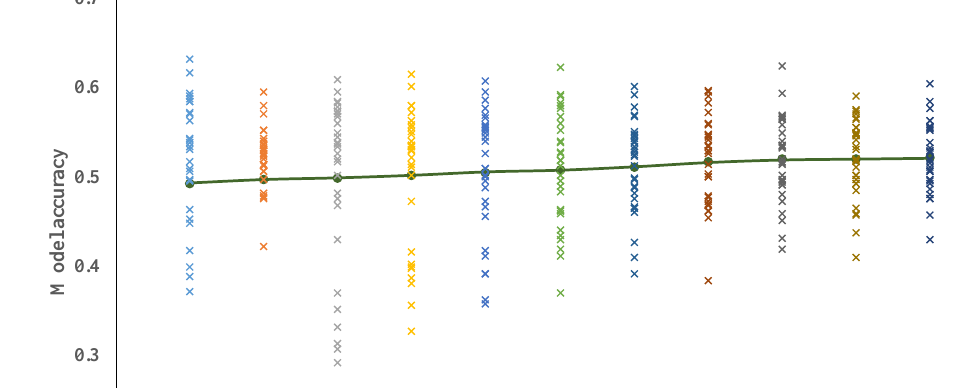
characteristics.